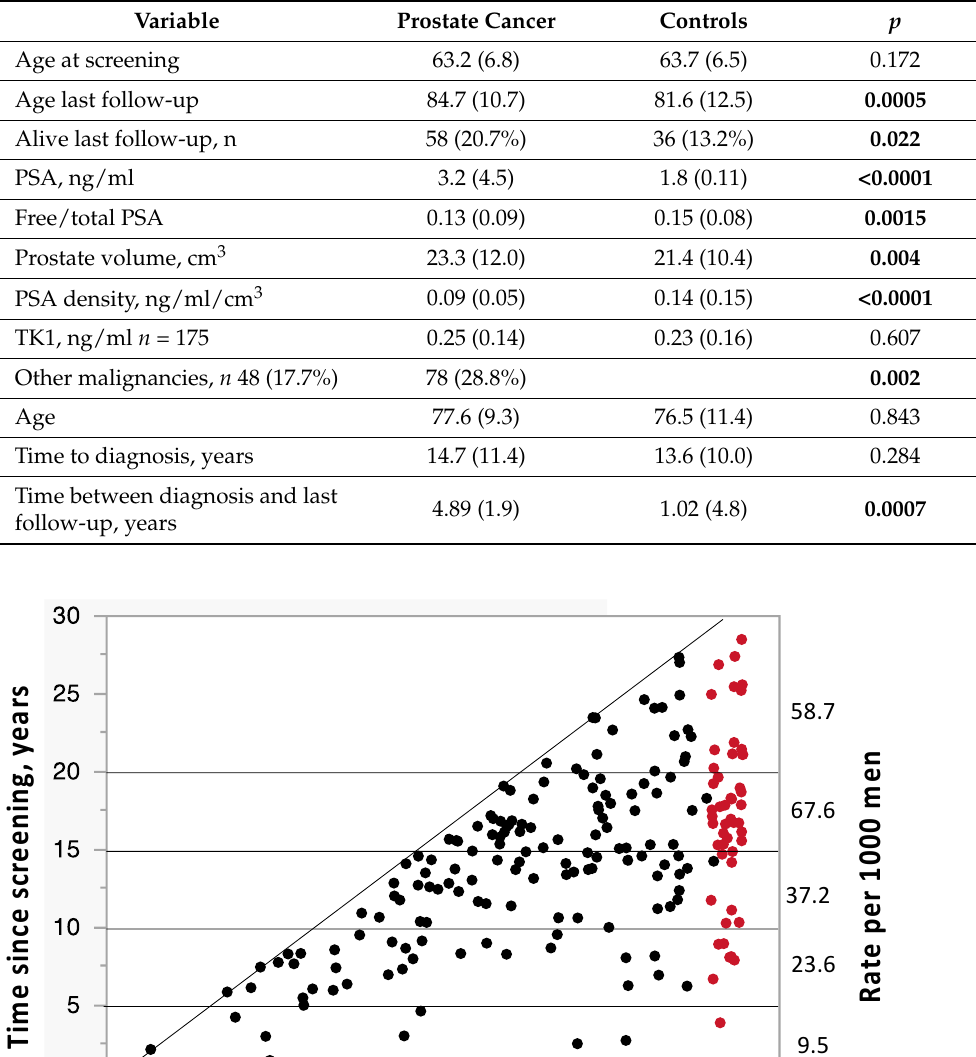
Table 1. Characteristics of 271 men with prostate cancer and 271 controls. Median values (IQR). Prostate-related characteristics and TK1 were obtained in connection with screening 1988–1989. Abbreviations: PSA = prostate-specific antigen, TK1 = thymidine kinase 1.